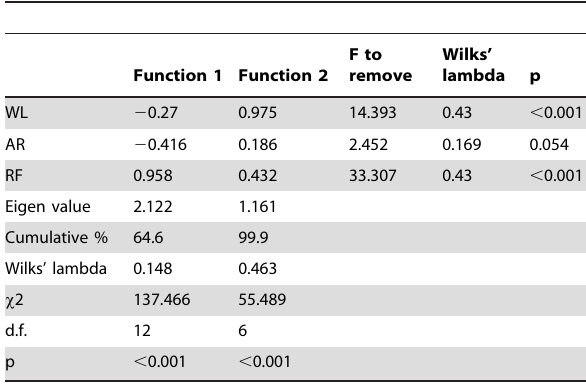
Groups correspond to Figure 2, WL = wing loading, AR = aspect ratio and RF = resting